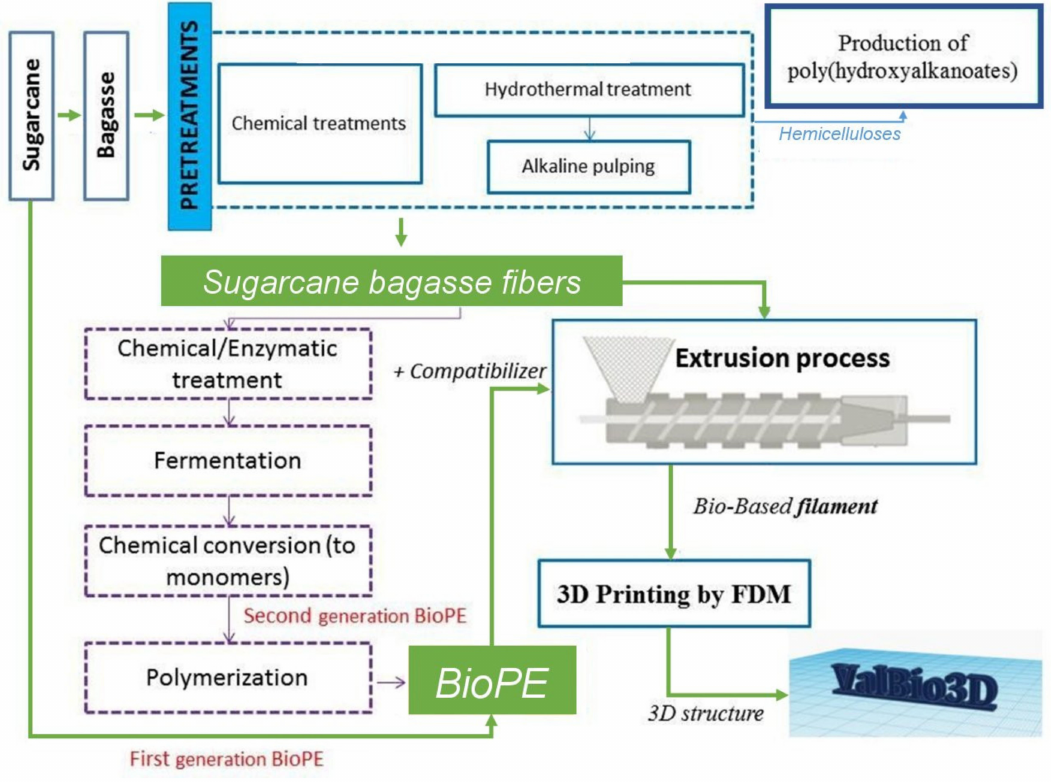
Figure 1. Scheme for the integral use of sugarcane, including the production of Bio-polyethylene (BioPE) and bagasse